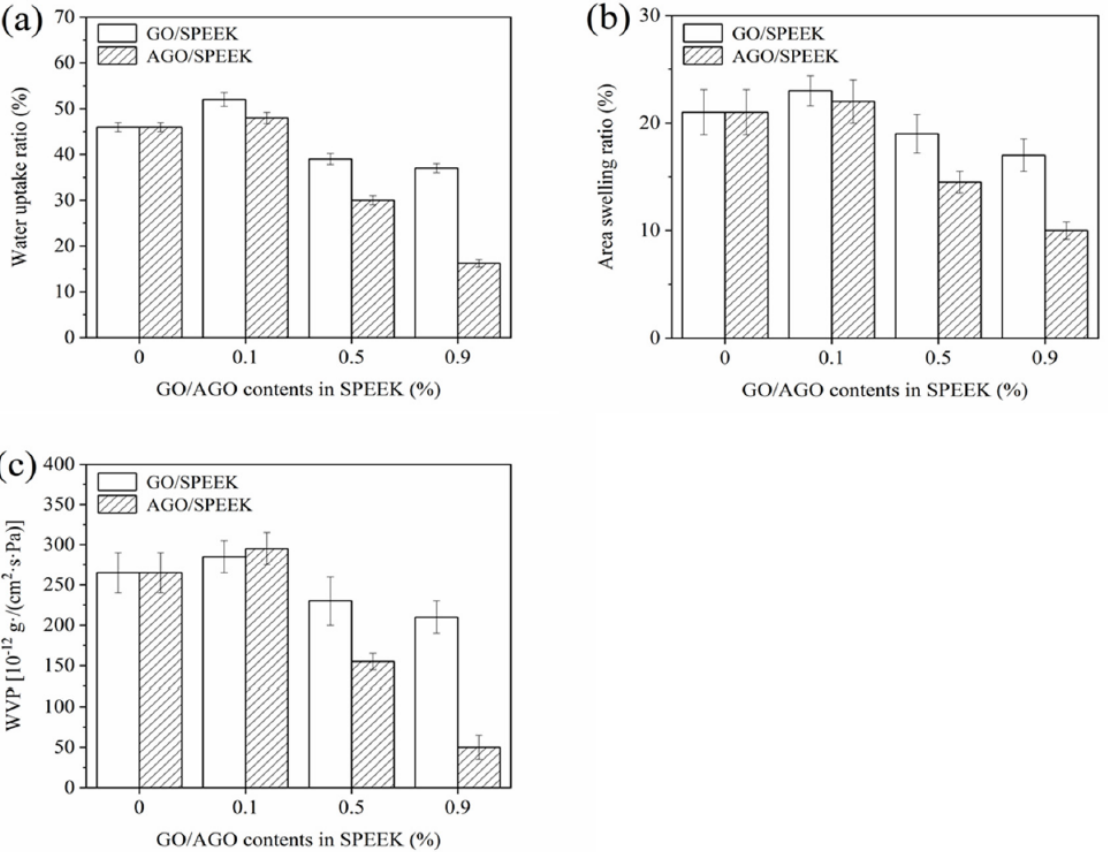
Figure 4. Water permeability of AGO/SPEEK films. ( a ) Water uptake ratio, ( b ) area swelling rate, ( c ) water vapor per- meability.